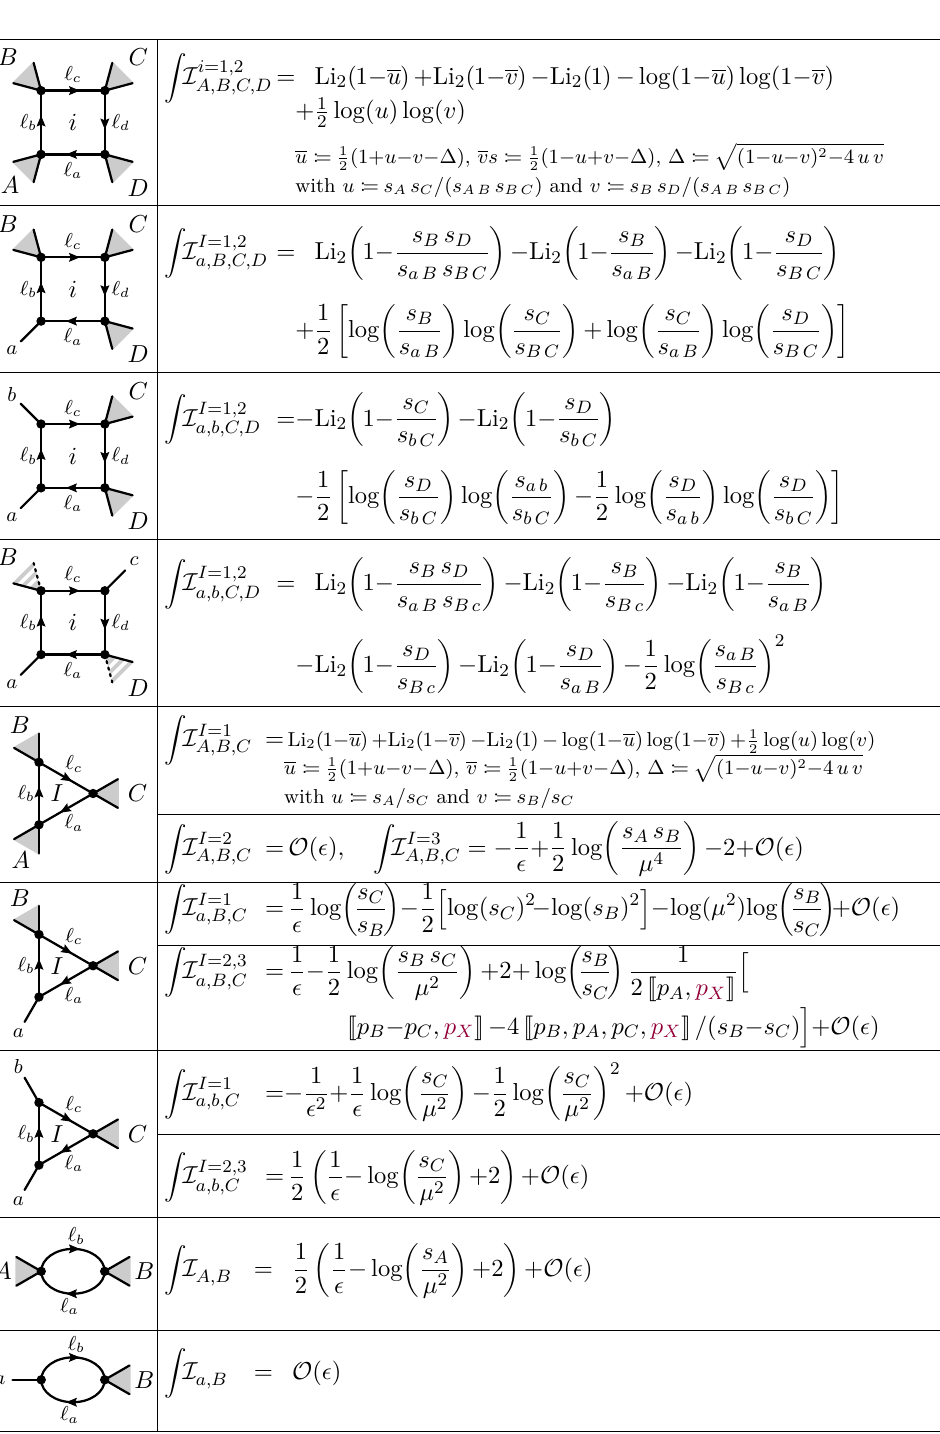
Table 5 . Integration results for all box, triangle, and bubble integrands in B (4)